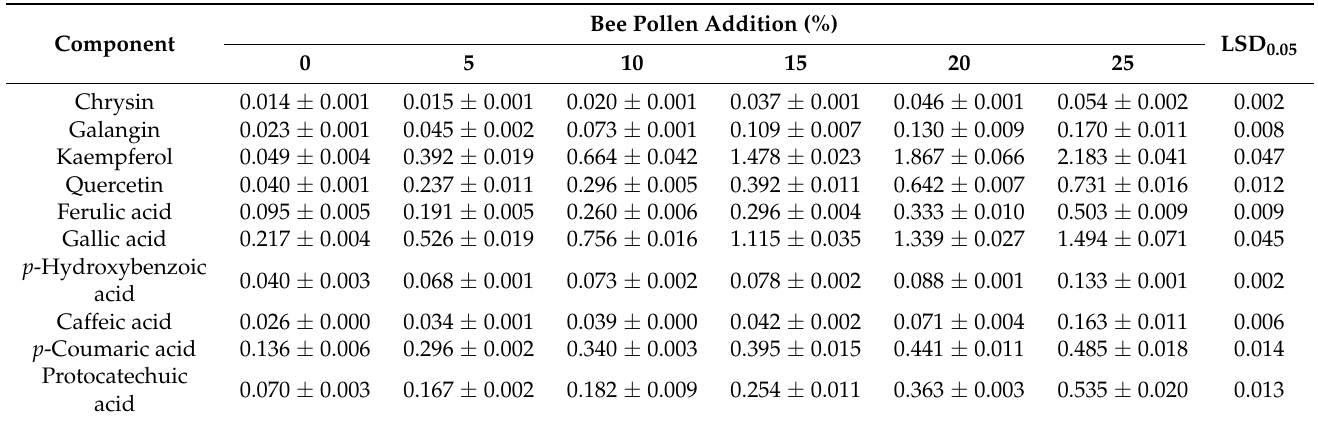
Bee Pollen Addition